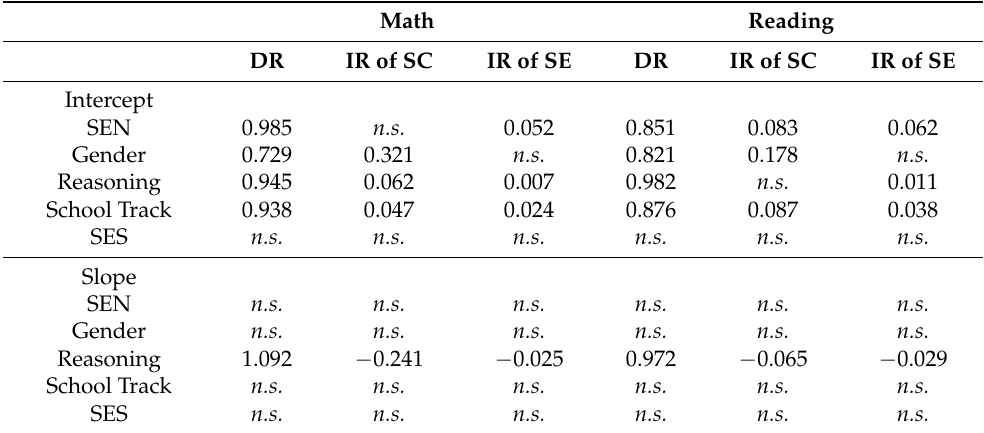
Table 6. Direct and indirect